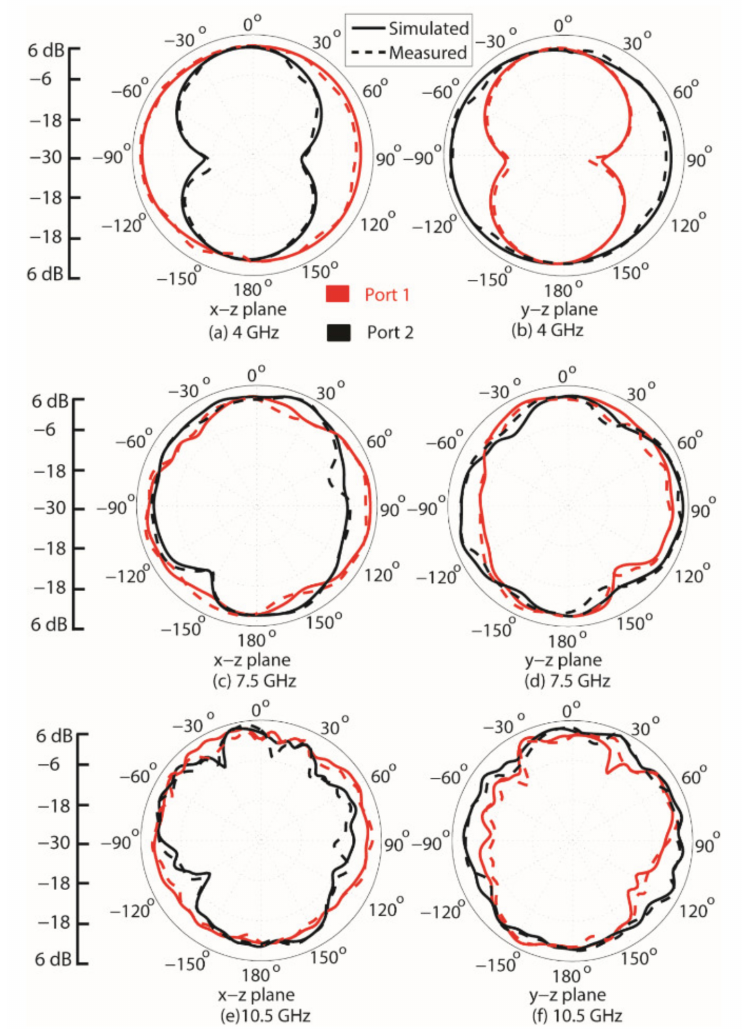
Figure 8. 2D Radiation patterns in X–Z and Y–Z planes at 4.0 GHz, 7.5 GHz, and 10.5